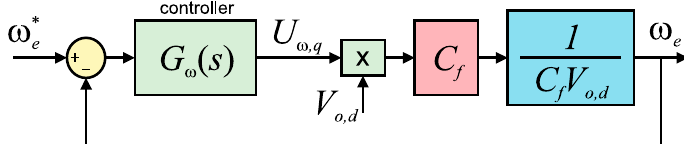
Figure 4. The frequency control loop.